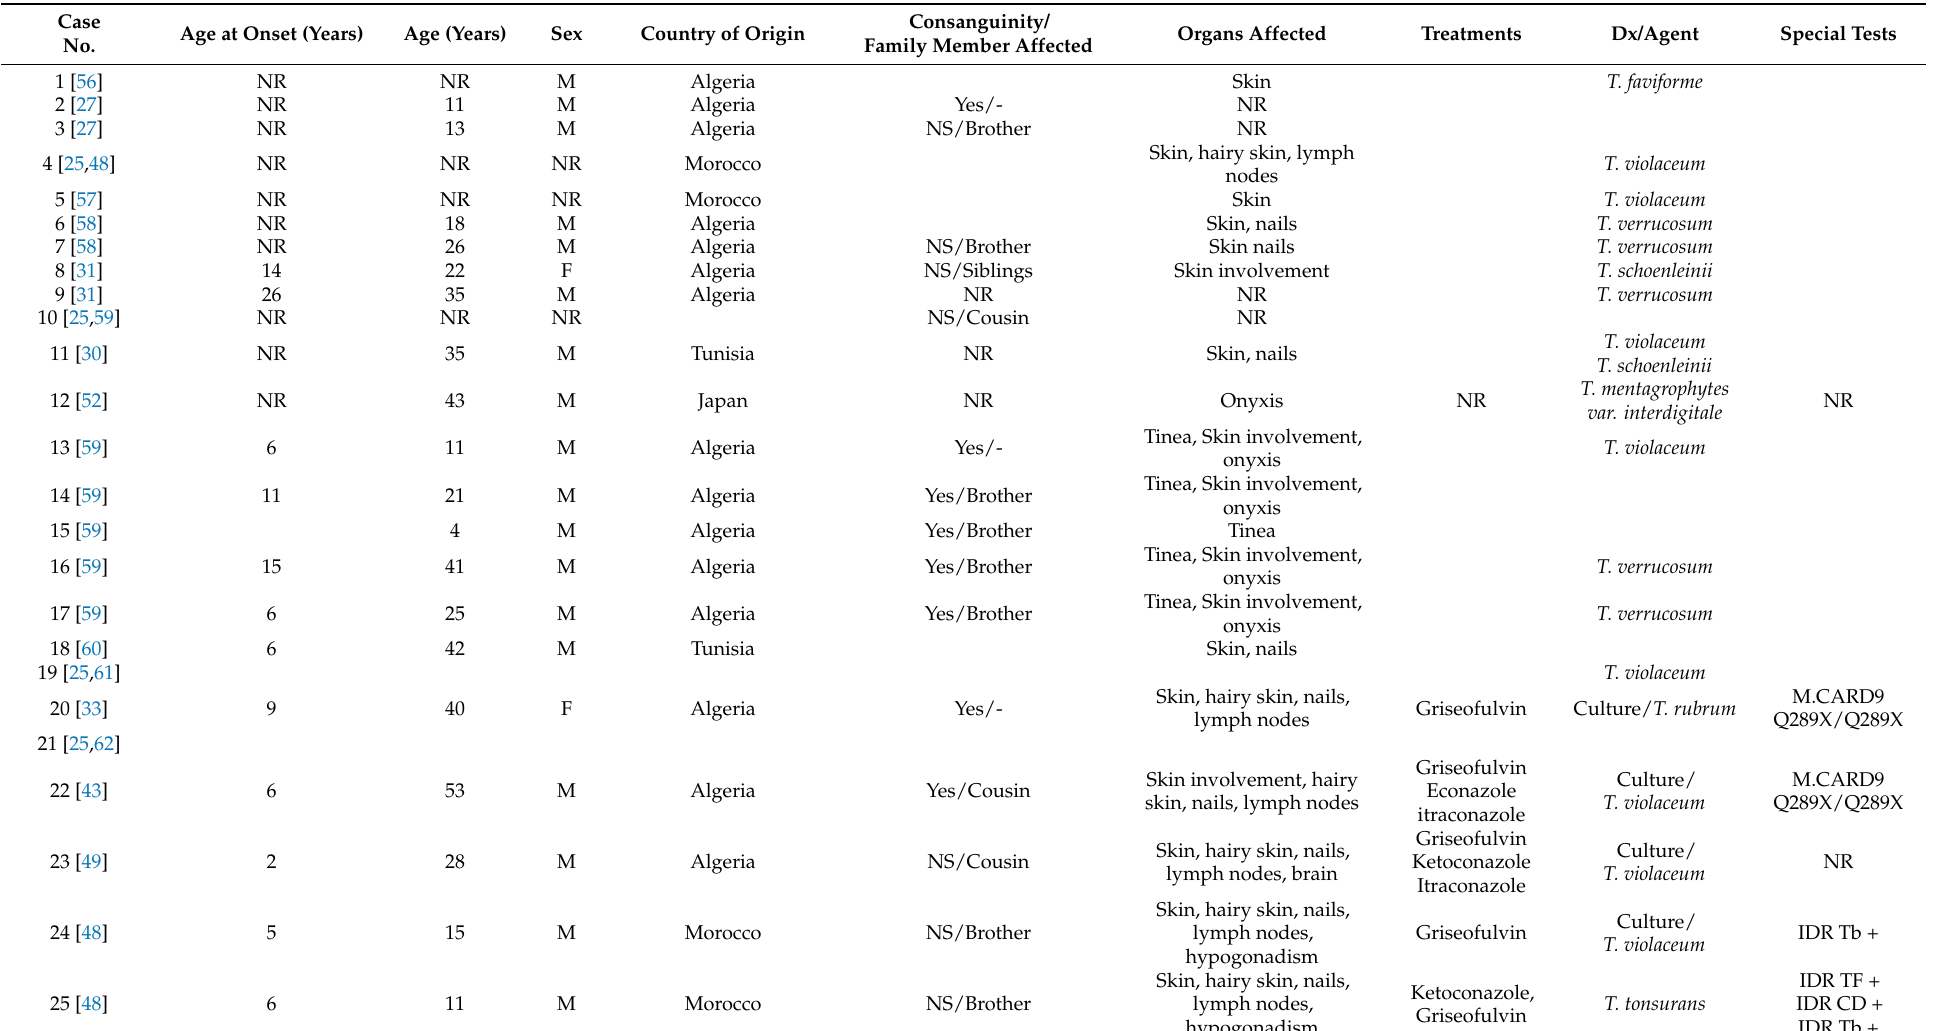
Table 1. Description of patients with deep/systemic dermatophytosis reported in the